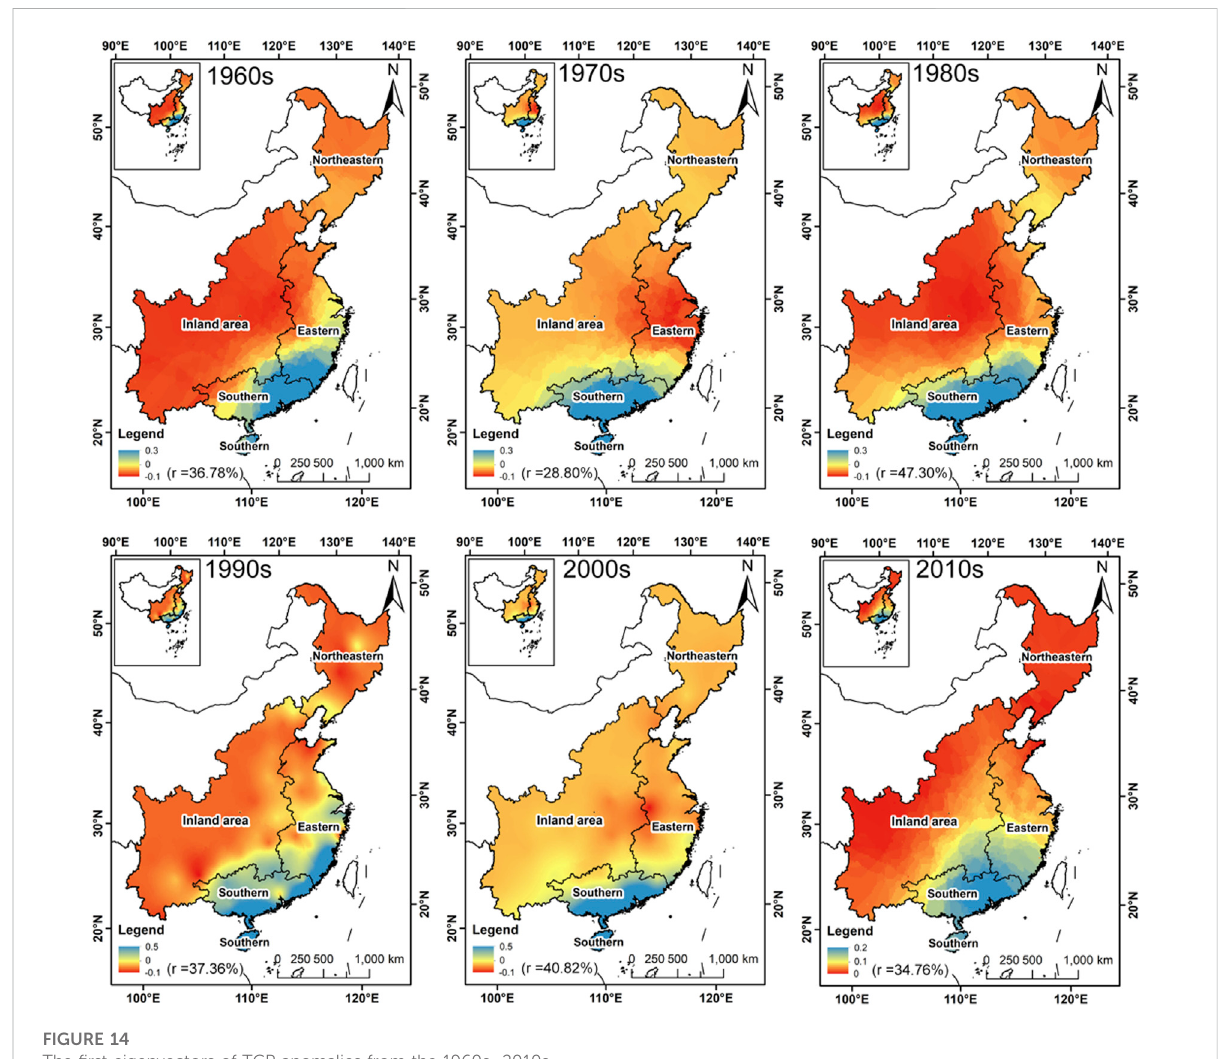
FIGURE 14 The fi rst eigenvectors of TCP anomalies from the 1960s – 2010s.